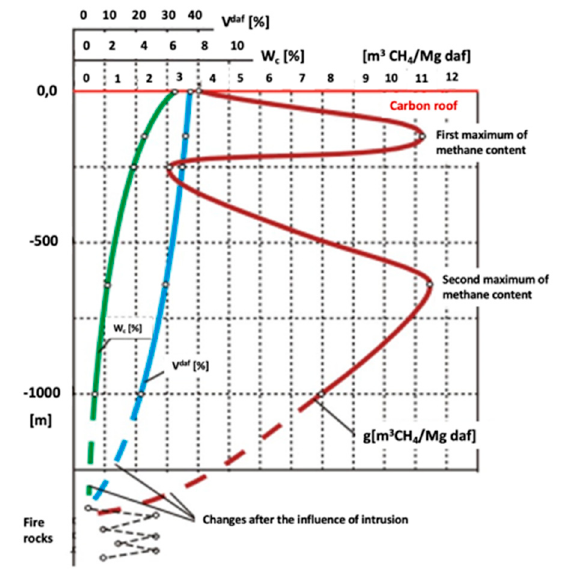
Figure 1. The averaged changes in methane content g , moisture content W c and volatile parts V daf in the coal deposits of the Rybnik Coal Basin. Adapted from Tarnowski J. 1971 [8].